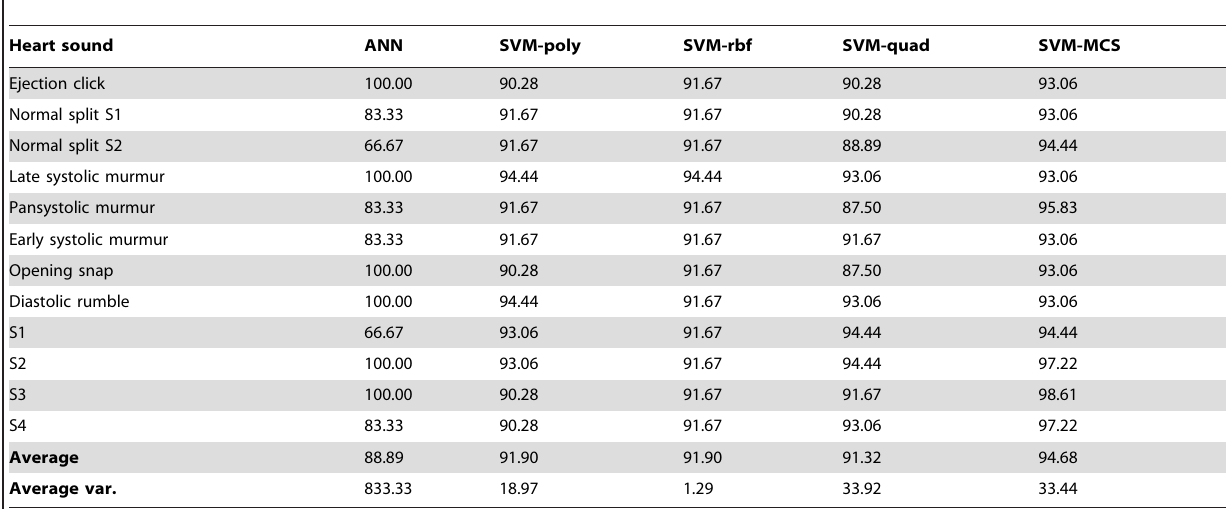
Table 2. Percentage of correctly classified signals for different heart sounds from a leave-one-out